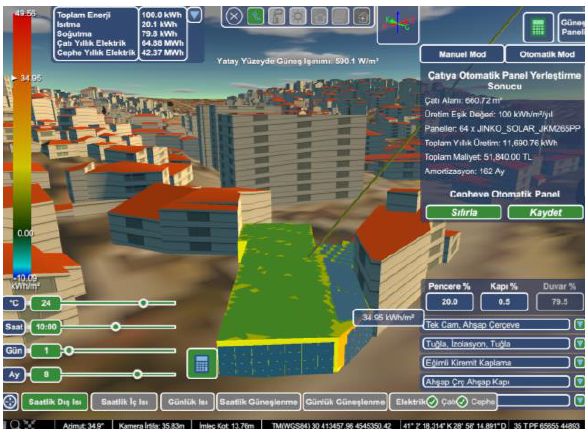
Figure 14. Solar estimation for buffered area (group of building).